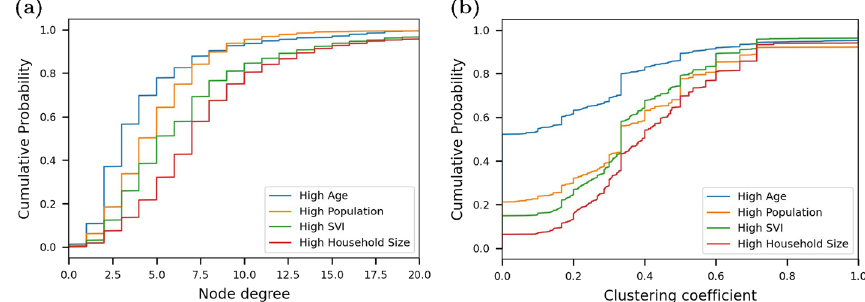
Fig. 3 Empirical cumulative distribution for a node degree and b clustering coefficient from a single realization of each